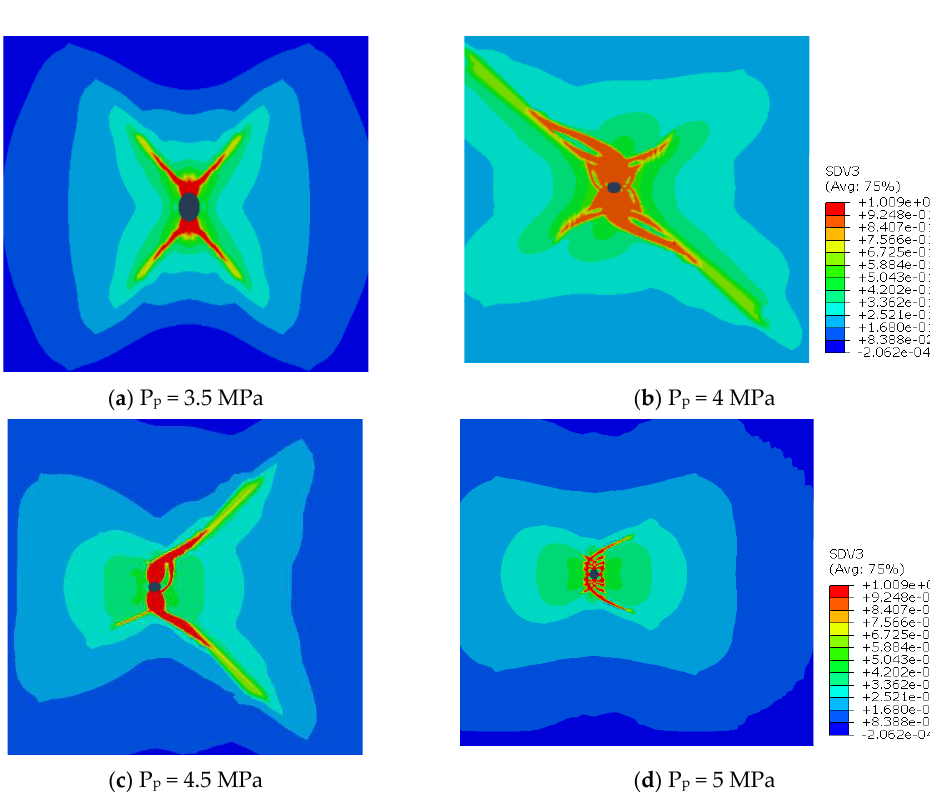
Figure 13. Evolution of damage factor with borehole pressure. The rock permeability, disturbance damage factor, and plastic strain area with dis- tance from the borehole along the direction of the node path are shown in Figure 14. As the distance from the borehole increases, the permeability, disturbance damage factor, and plastic strain gradually decrease. Under the low hydrostatic pressure of drilling fluid, the rock permeability, disturbance damage factor, and equivalent plastic strain fluctuate slightly, and the damage position is determined. Under the high borehole pressure, the